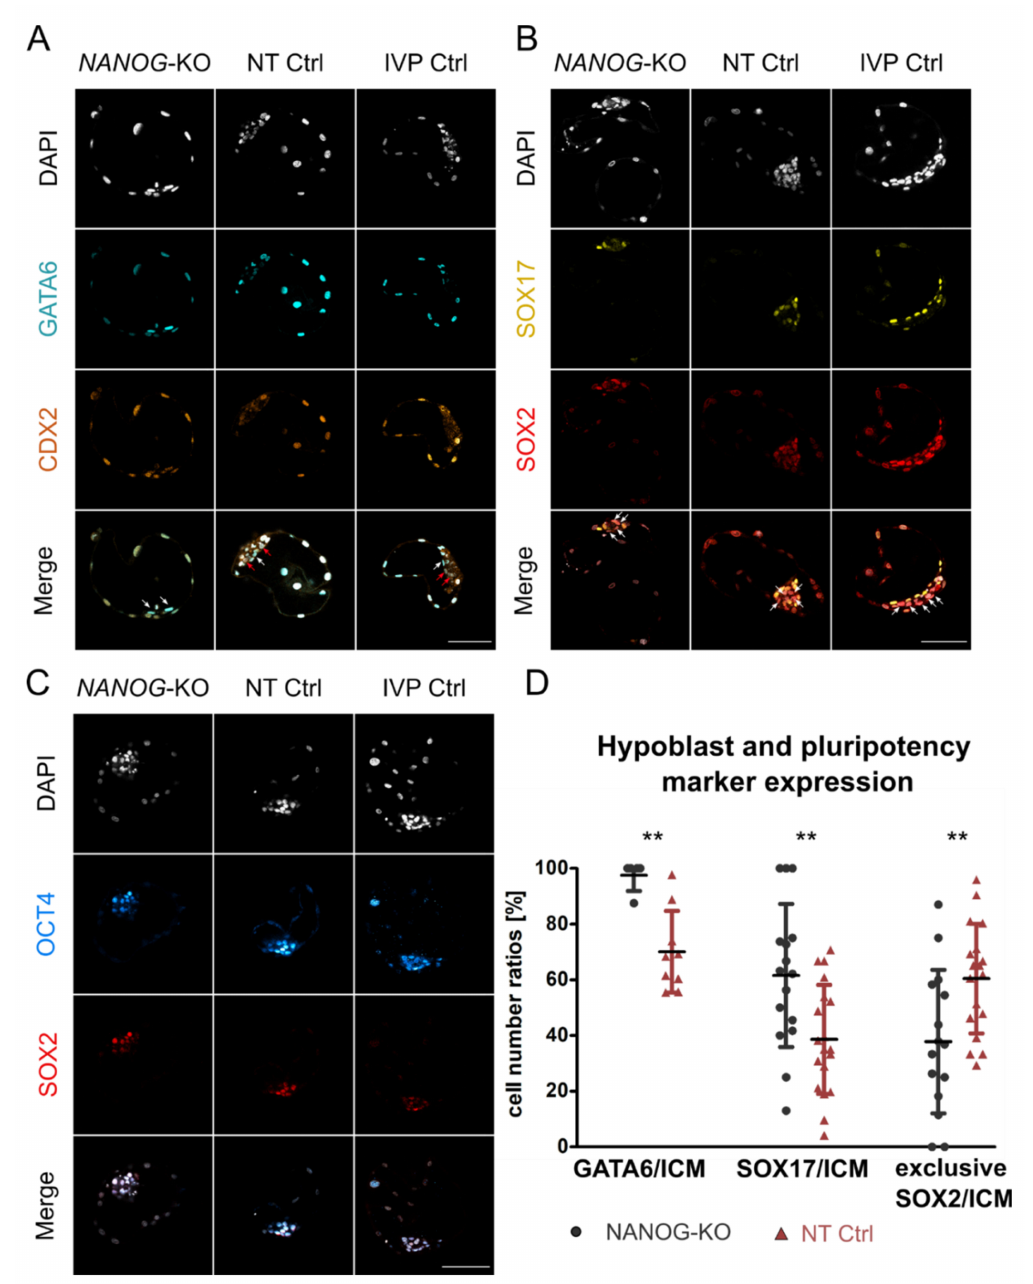
Figure 1. Expression of hypoblast and pluripotency markers in NANOG -KO and control groups. Representative confocal planes of day 8 blastocysts stained for GATA6/CDX2 ( A ) and SOX17/SOX2 ( B ). Sample sizes of GATA6/CDX2 were n = 5, 9, 14 and of SOX17/SOX2 n = 16, 18, 10 for NANOG -KO, NT Ctrl, and IVP Ctrl, respectively. White arrows indicate ICM cells with GATA6 expression ( A ) or exclusive SOX2 expression ( B ), red arrows indicate GATA6/CDX2 double negative cells ( A ) in the ICM. ( C ) Expression of pluripotency factors OCT4 and SOX2. Sample sizes were n = 4, 9, 4 for NANOG -KO, NT Ctrl, and IVP Ctrl, respectively. Color codes were: Grey (DAPI), cyan (GATA6), orange hot (CDX2), yellow (SOX17), red (SOX2), and cyan hot (OCT4). ( D ) The ratio of GATA6, SOX17, and SOX2 positive cells within the ICM of NANOG -KO (black) and NT Ctrl (red) embryos. SOX2 served as ICM marker in the quantification of SOX17. SOX2 exclusive expression represents cells positive for SOX2 while negative for SOX17. Data were analyzed using a two-tailed Mann–Whitney U test and are presented as mean (%) ± standard deviation. Asterisks (**) indicate significant differences between groups ( p < 0.01). Sample sizes of GATA6 were n = 5, 9; of SOX17 n = 16, 19; and of SOX2 exclusive n = 15, 18 for NANOG -KO and NT Ctrl embryos, respectively. Scale bars indicate 100 µ